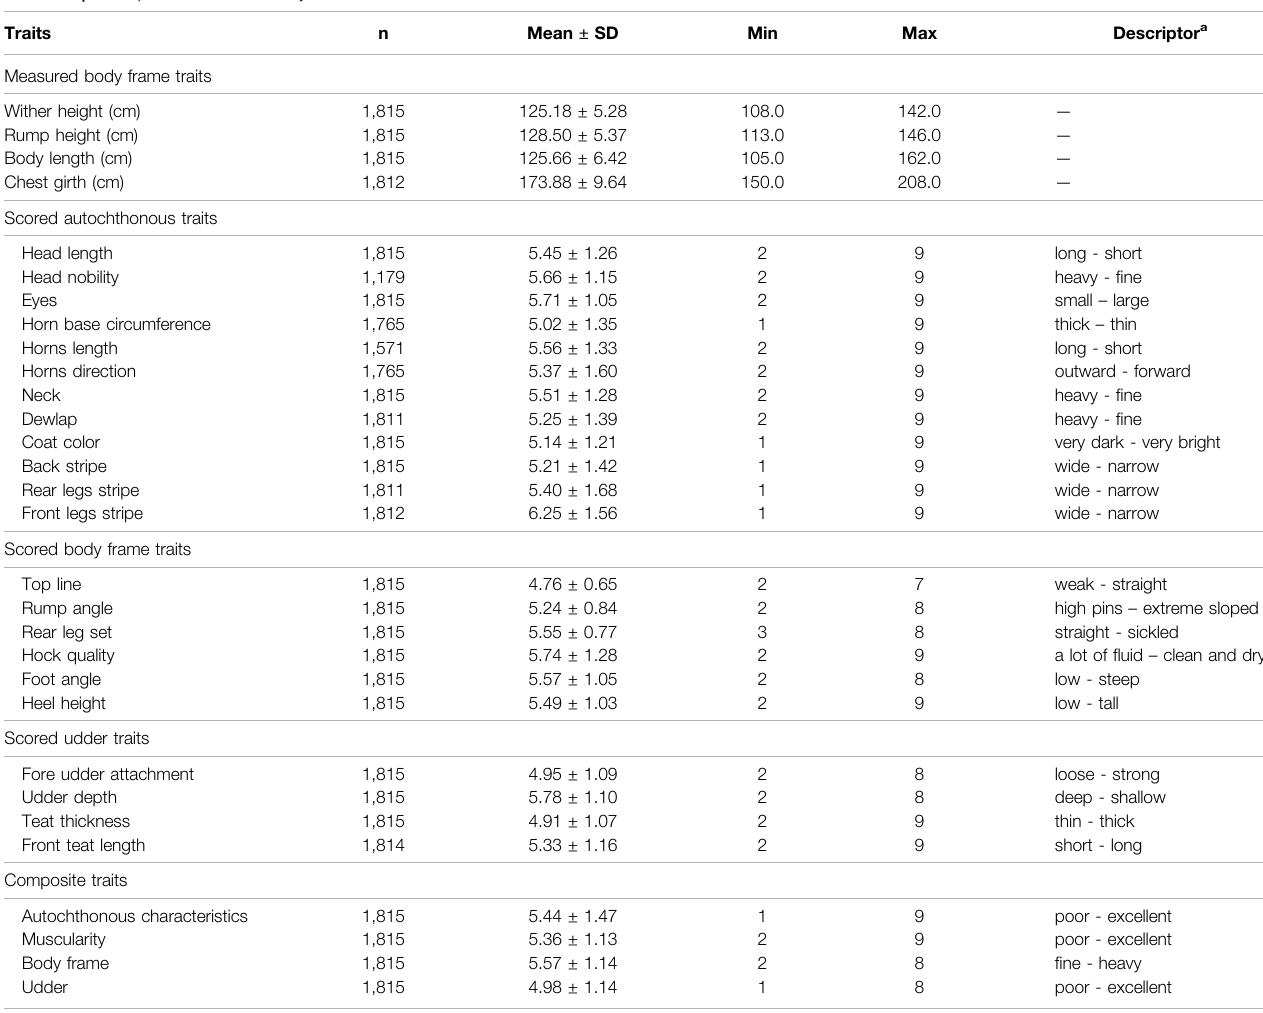
TABLE 1 | Descriptive statistics of analyzed